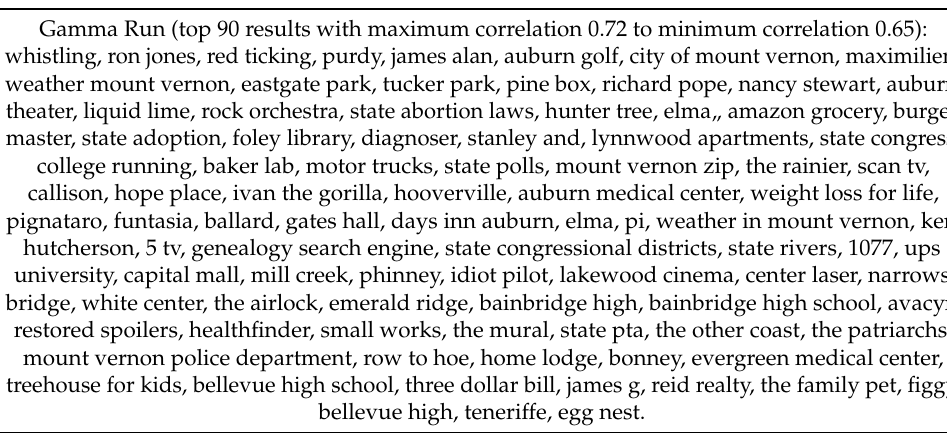
Table 1. Examples of 90 most correlated search terms from sample gamma and random walk runs. Gamma Run (top 90 results with maximum correlation 0.72 to minimum correlation